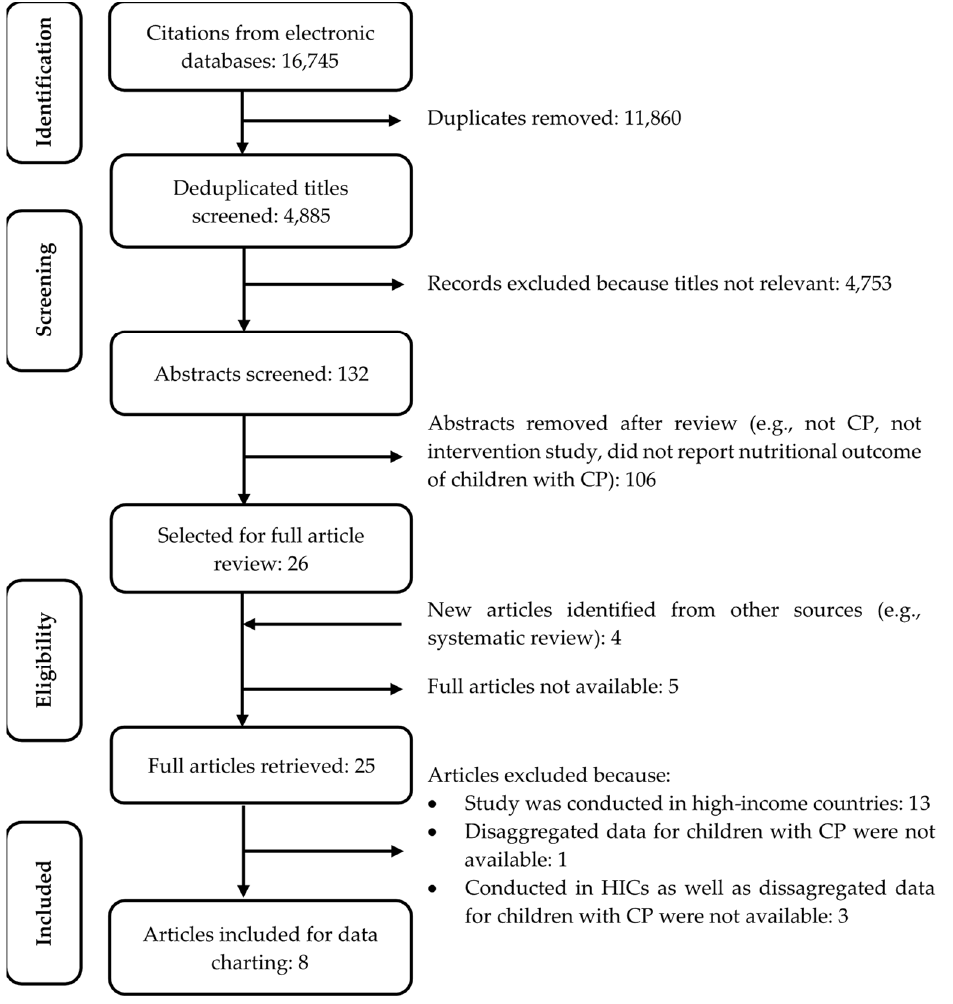
Figure 1. Flow diagram of study selection procedure; CP, Cerebral Palsy.